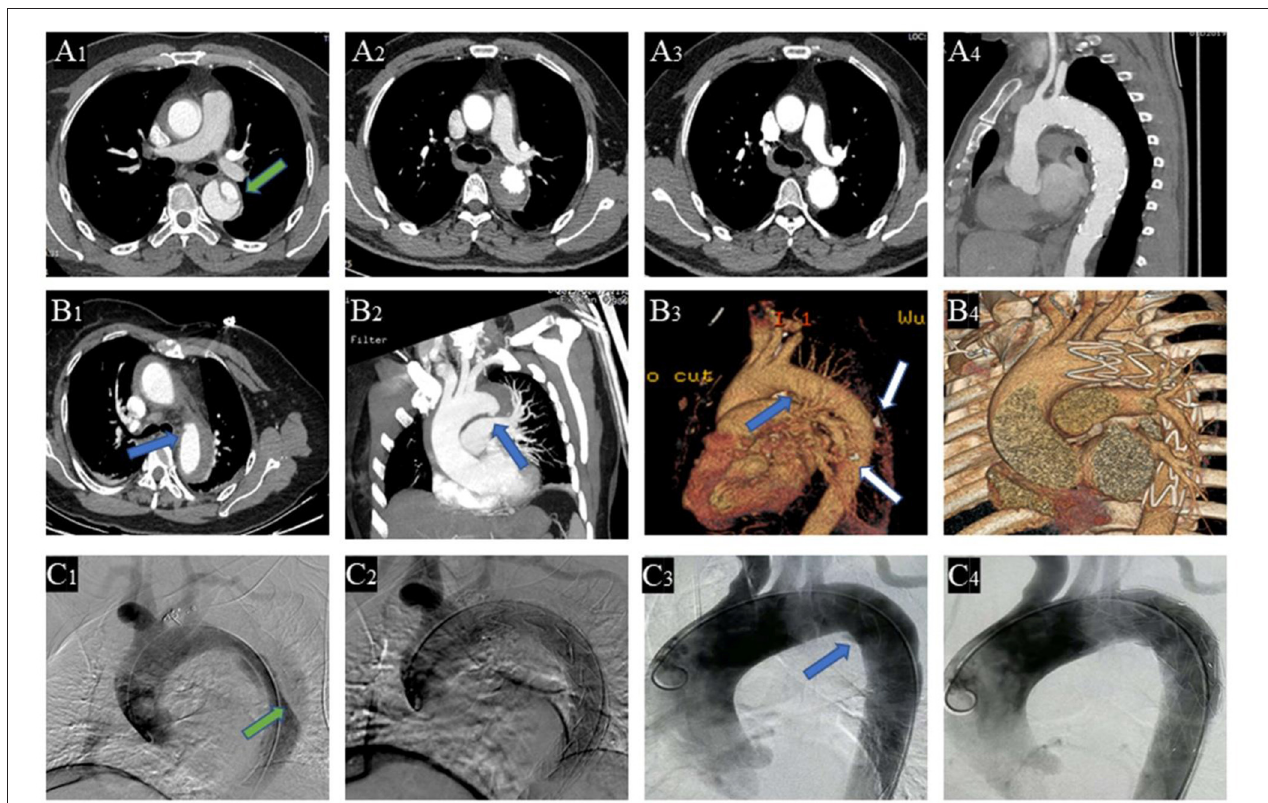
FIGURE 1 | Contrast-enhanced computed tomography angiography (CTA) of the patients with retrograde type A aortic intramural hematoma (TAIMH). A patient with entry tear (green arrow) in descending aorta was treated by thoracic endovascular aortic repair (TEVAR), and the image was collected at admission (A 1 ) , 2 weeks after TEVAR (A 2 ) , and 3 months after TEVAR (A 3,4 ) , respectively. Another patient with penetrating atherosclerotic ulcer (PAU, blue arrow) and calcification plaque (white arrow) at admission (B 1 − 3 ) and 2 weeks after TEVAR (B 4 ) , respectively. Intraoperative angiography of the two patients with retrograde TAIMH before ( C 1 , entry tear, green arrow; C 3 , PAU, blue arrow) and after implanting stent grafts ( C 2 , entry tear was blocked; C 4 , PAU was